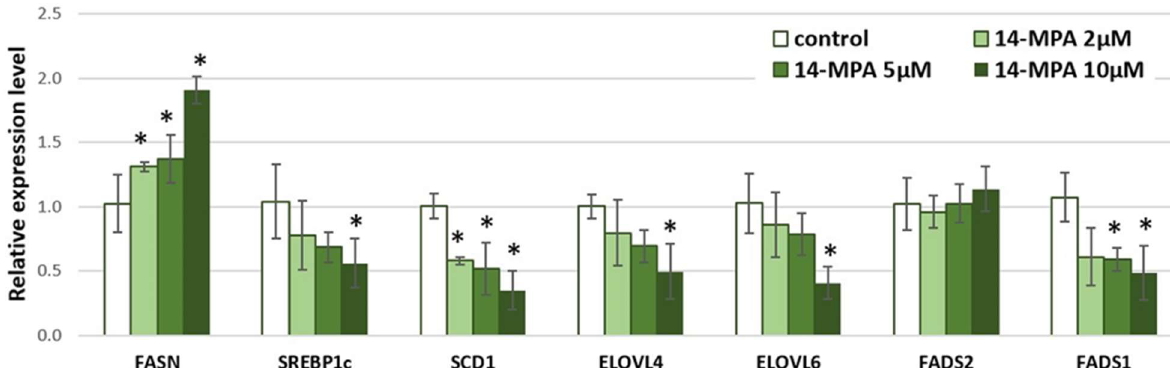
Figure 2. Relative expression level of selected genes involved in fatty acid synthesis and metabolism in visceral adipocytes incubated for 48h in different concentrations of 14-methylpentadecanoic acid (14-MPA). Data are presented as mean ± SD. * p < 0.05 compared to control. FASN —fatty acid synthase; SREBP1 —sterol regulatory element-binding protein 1; SCD1 —stearoyl-CoA desaturase; ELOVL4 —fatty acid elongase 4; ELOVL6 —fatty acid elongase 6; FADS2 —fatty acid desaturase 2; FADS1 —fatty acid desaturase 1.